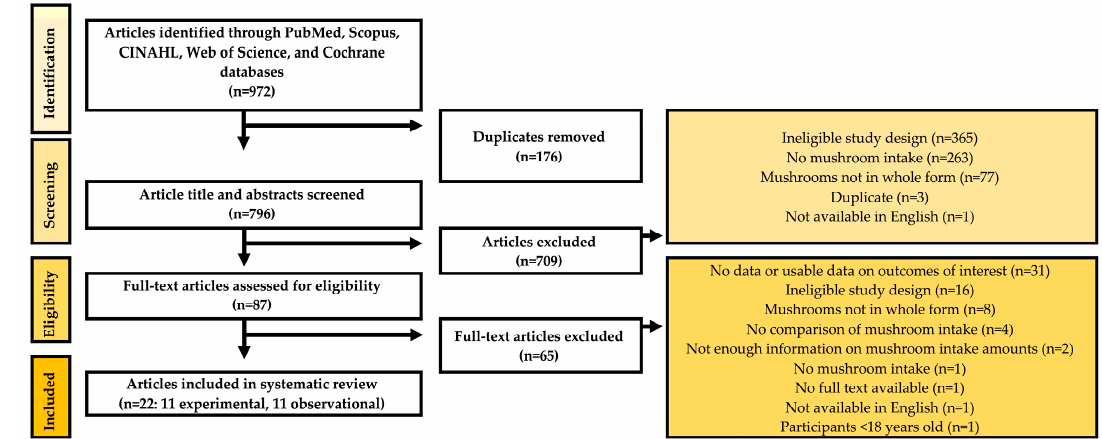
Figure 1. PRISMA flow diagram of the article screening and inclusion